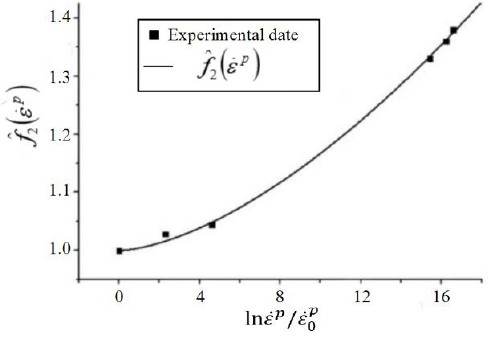
where σ is flow stress, 𝜀 𝑝 is plastic strain, 𝜀̇ 𝑝 represents the current strain rate, 𝜀̇ 0𝑝 is the reference strain rate, and m is the material constant. The relation curve between 𝑓̑ (𝜀̇ 𝑝 ) and dimensionless parameter ln𝜀̇ 𝑝 𝜀̇ 0𝑝 ⁄ is shown in Figure 5. Figure 5. The relation curve between 𝑓̑ 2 (𝜀̇ 𝑝 ) and ln𝜀̇ 𝑝 /𝜀̇ 0𝑝 [17]. With the help of the modified model (Equations (15) and (16)), the rheological properties of DP600 steel were predicted at strain rates of 10 − 3 s −1 , 10 − 2 s −1 , 500 s −1 , 1100 s −1 , and 1600 s −1 , respectively, and the predict results are shown in Figure 6. Compared with the experimental results, the modified KH model can better describe the deformation behavior of DP600 steel at a high strain rate.